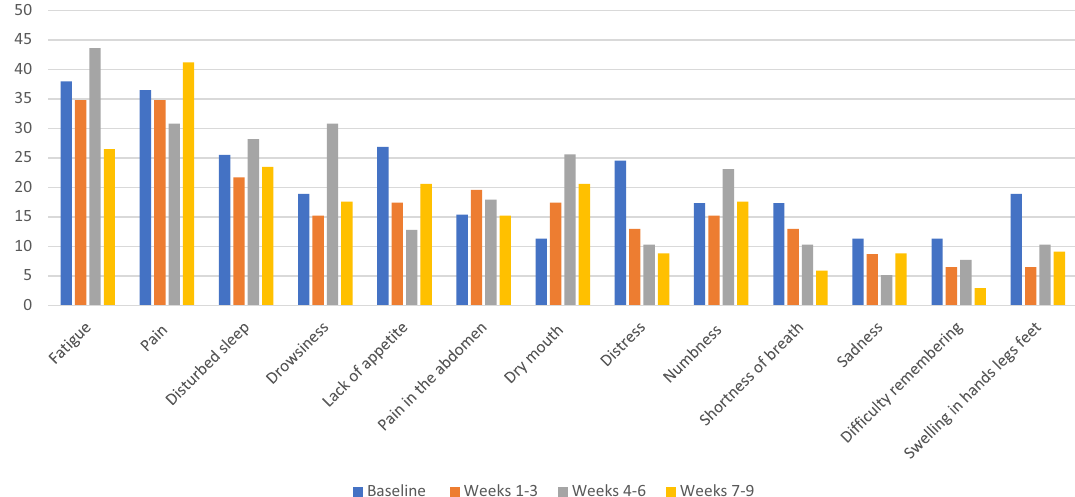
Figure 2. Percentage of patients with moderate-to-severe severity (MDASI scores greater than or equal to 5 on a 0–10 scale) of top 13 symptoms at baseline, weeks 1–3, weeks 4–6, and weeks 7–9 of treatment with pembrolizumab.